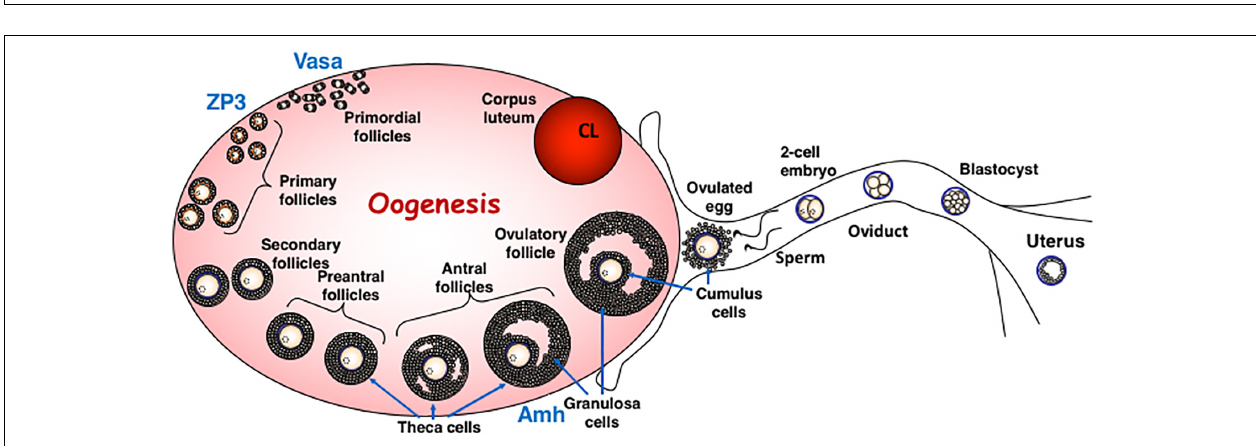
FIGURE 1 | Cell Surface Glycans in Mammals. The diagram depicts one or more glycans from each class of mammalian glycan. The diagram is modified from Figure in Stanley (2016) with permission. Sugar symbols are according to the Symbol Nomenclature for Glycans (Varki et al., 2015).